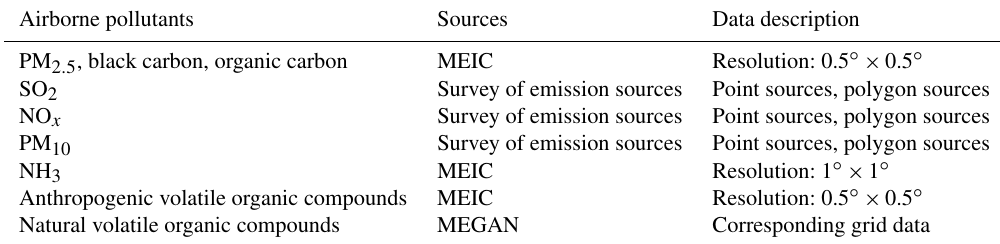
Table 1. Sources of emission